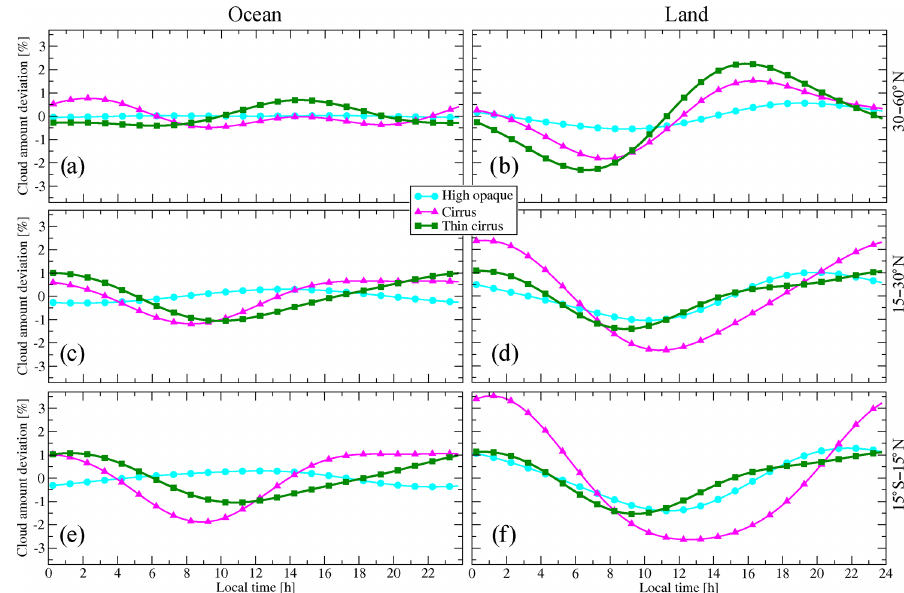
Figure 4. Diurnal cycle of high opaque, cirrus, and thin cirrus coverage in NH mid-latitudes, NH subtropics and tropics in boreal summer: (a) 30–60 ◦ N, ocean; (b) 30–60 ◦ N, land; (c) 15–30 ◦ N, ocean; (d) 15–30 ◦ N, land; (e) 15 ◦ S–15 ◦ N, ocean; (f) 15 ◦ S–15 ◦ N, land. The AIRS/IASI statistics is averaged for